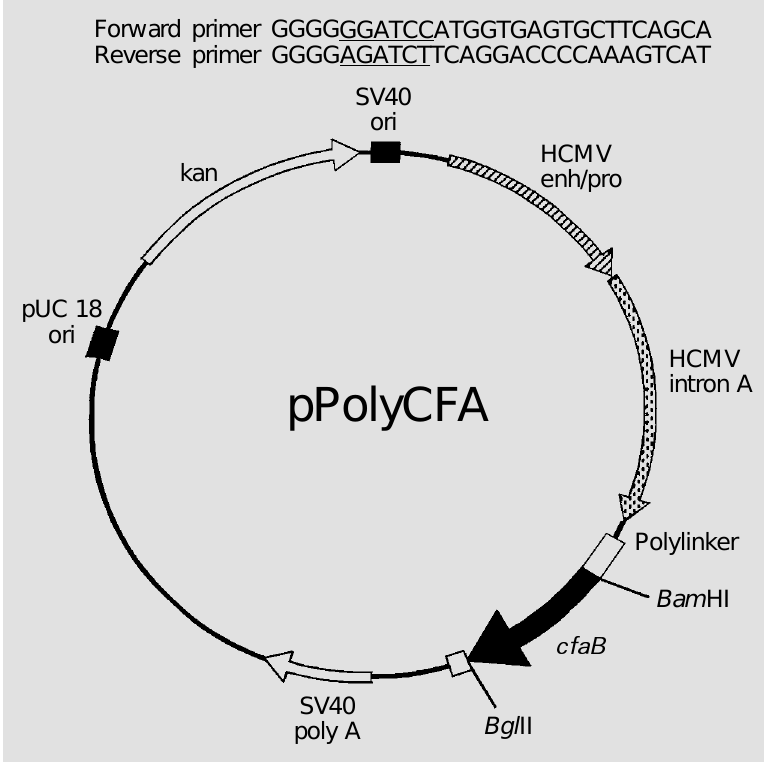
Figure 3 - Schematic representation of pPolyCFA. Forward and reverse primers containing restriction sites (underlined sequences) for Bam HI and Bgl II, respectively, were used to amplify a synthetic gene encoding the mature CFA/I subunit ( cfaB ). pkCMVintPoly was digested with such enzymes, as well as the PCR-generated cfaB gene fragment. The resulting cfaB gene was cloned in the pkCMVintPoly polylinker region. HCMV, Human